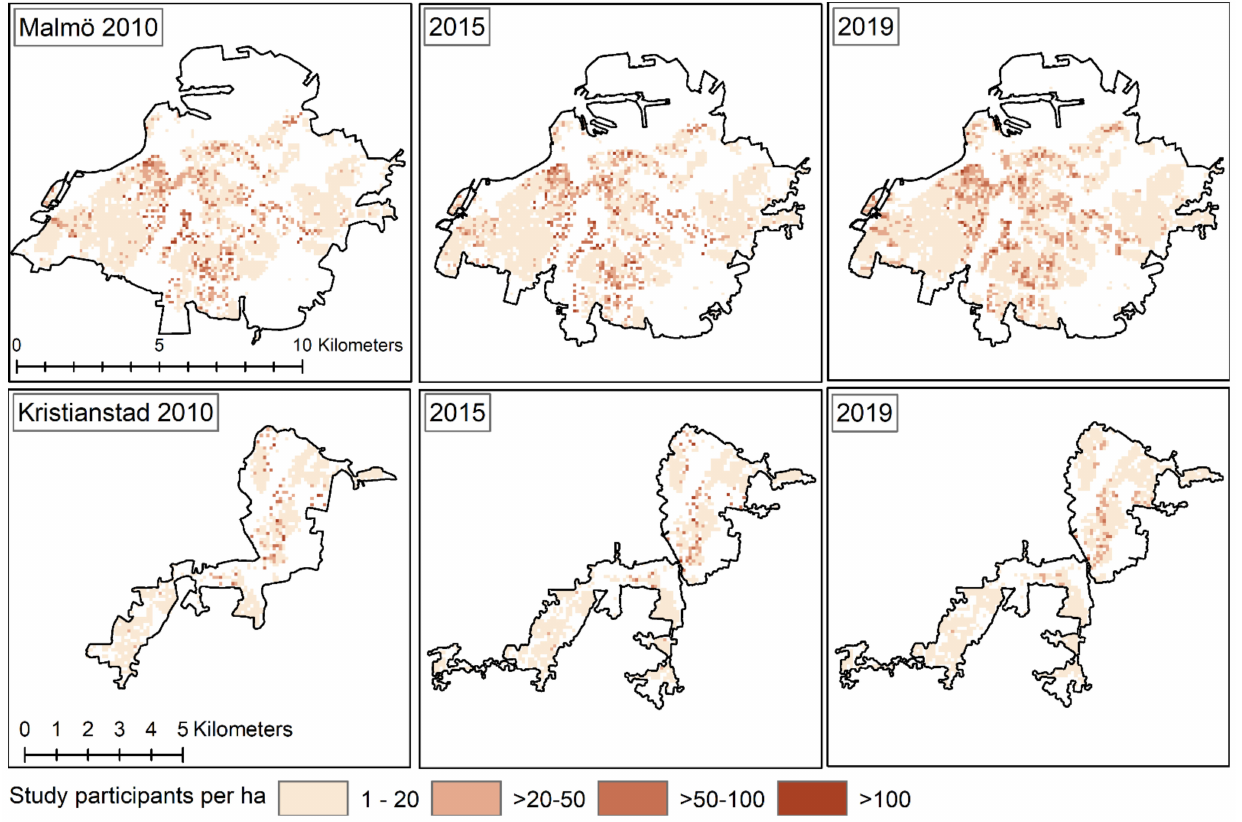
Figure 2. Residential density of persons 65 years or older in Malmö and Kristianstad city, within respectively municipality in 2010, 2015 and